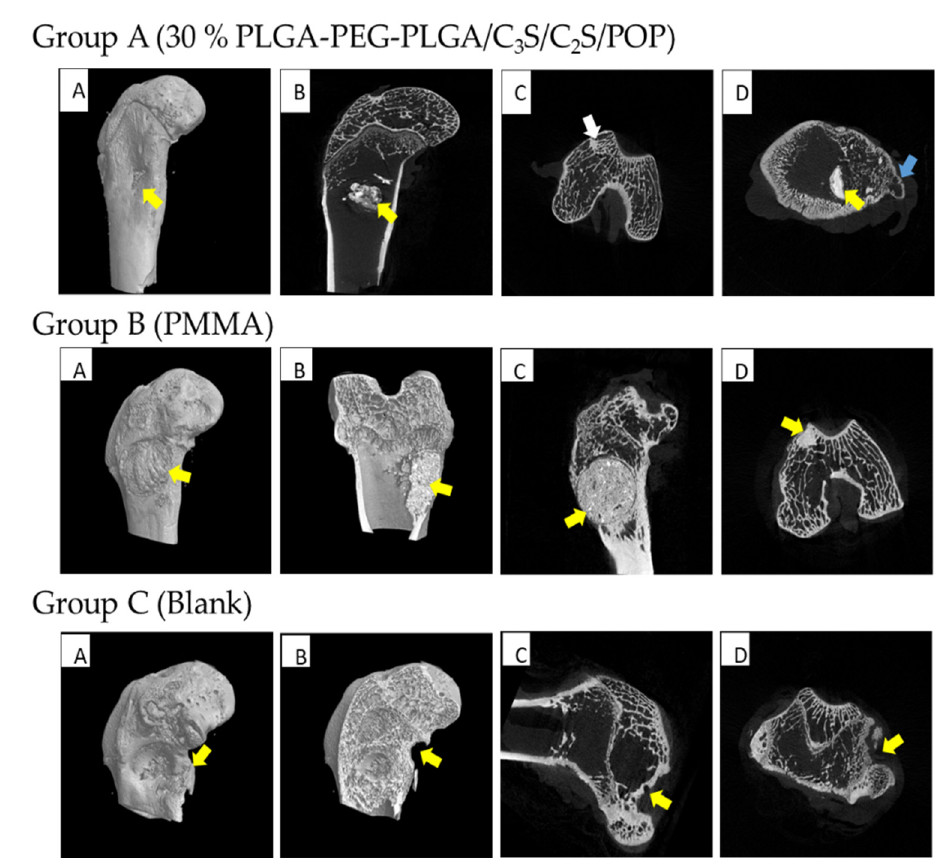
Figure 15. MICRO-CT results of femoral condyles and implant material 12 weeks after operation. Group A (30% PLGA–PEG–PLGA/C3S/C2S/POP): ( A ) three-dimensional reconstruction, ( B – D ) sagittal, coronal, and horizontal planes, respectively. The yellow arrow pointed to the composite bone cement filler, and the filler was partially degraded, so the bone defect could be completely healed. The white arrow pointed to the new bone trabecula. The blue arrow indicates a nascent callus. Group B (PMMA): ( A , B ) reconstructed in three dimensions, and ( C , D ) sagittal and coronal, respec- tively. The location pointed by the yellow arrow was the filling material of PMMA bone cement. The filling material did not degrade, and the boundary with the surrounding bone substance was clear. Group C (Blank): ( A,B ) three-dimensional reconstruction map, ( C ) sagittal plane, and ( D ) cor- onal plane. The yellow arrow pointed to the defect of the femoral condyle, there was little generation of new bone trabeculae, and no complete healing was observed.